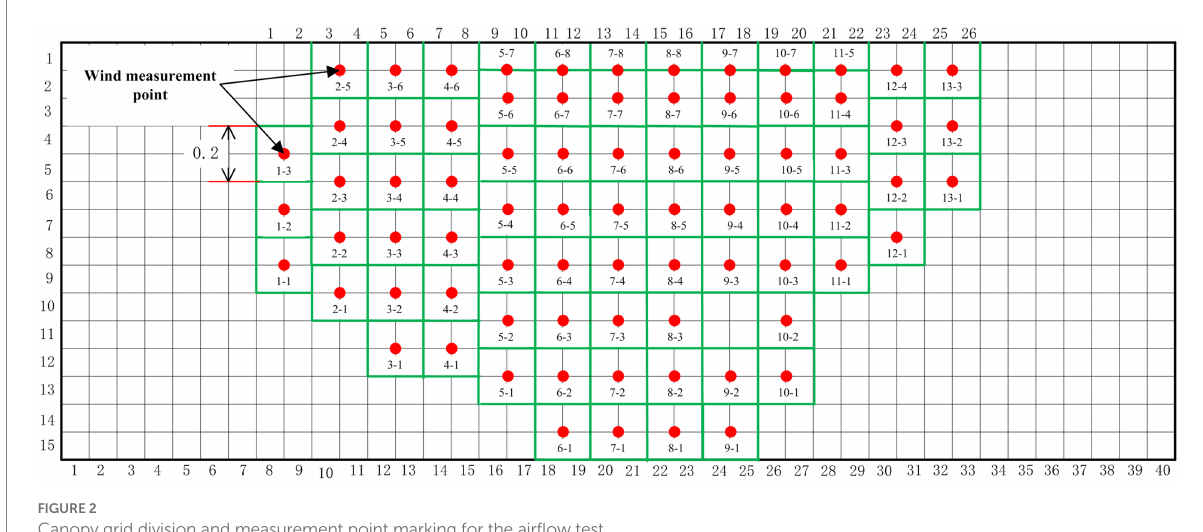
FIGURE 2 Canopy grid division and measurement point marking for the airflow test.